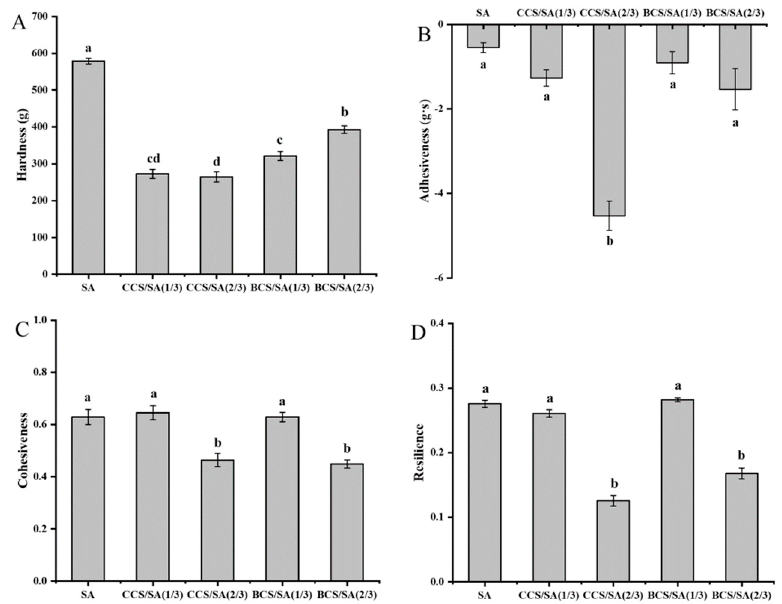
Figure 3. Textural properties of the SA, CCS/SA (1/3), CCS/SA (2/3), BCS/SA (1/3), and BCS/SA (2/3) hydrogels: ( A ) Hardness. ( B ) Adhesiveness. ( C ) Cohesiveness. ( D ) Resilience. Different lowercase letters (a–d) indicate significant differences ( p < 0.05).